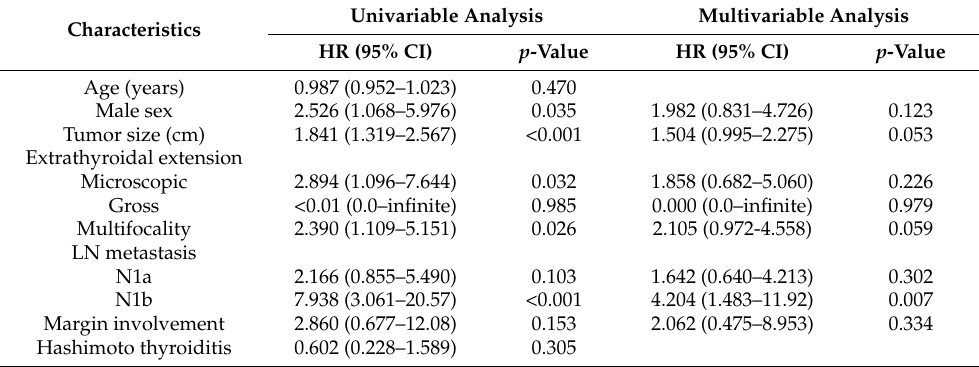
Table 3. Cox proportional hazards analysis for predictive factors of PTC recurrence.